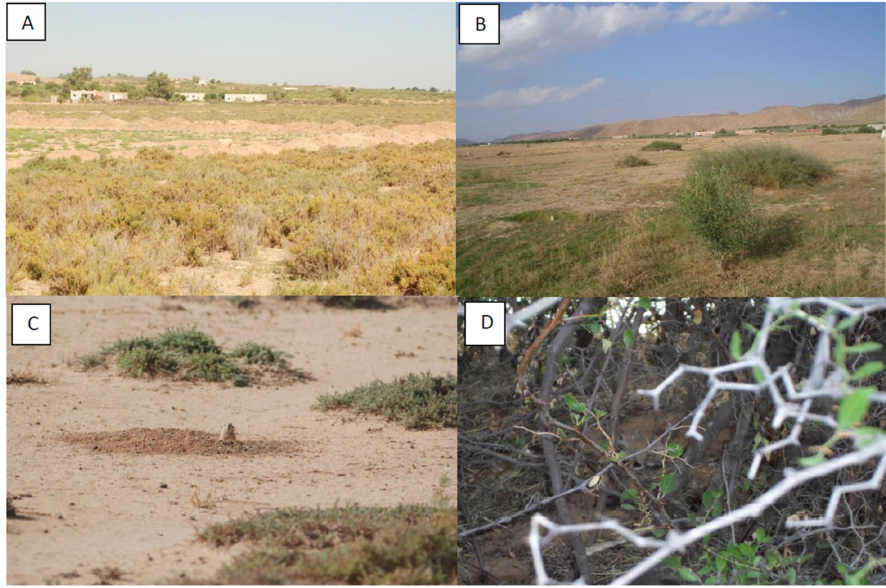
Figure 2. Ecotone of Psammomys obesus ( A , B ) and Meriones shawi ( C , D